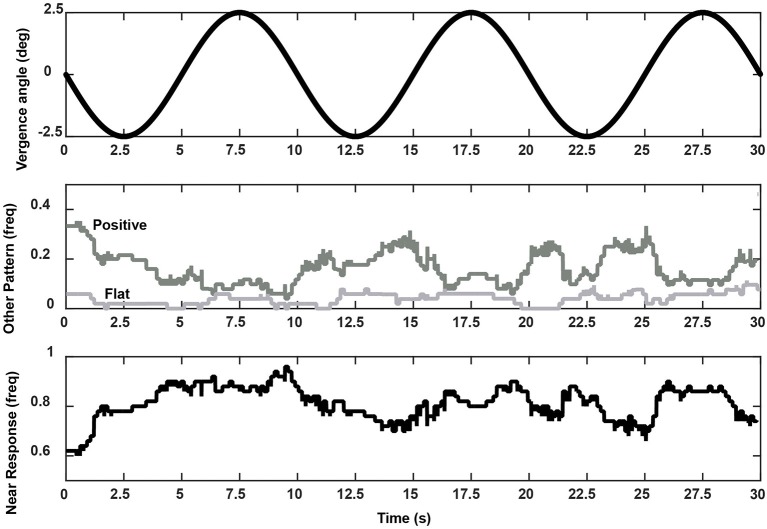
Frequency of occurrence of a coordinated near response segment (i.e., pupil constriction-convergence/pupil dilation-divergence linear relationship, lower panel), positive slope segment (i.e., pupil dilation-convergence/pupil constriction-divergence linear relationship), or flat relationship (middle panel) during the vergence task. These summaries are taken from pooled data from all 52 subjects. The upper trace shows the stimulus pattern (divergence negative re: baseline tropia).